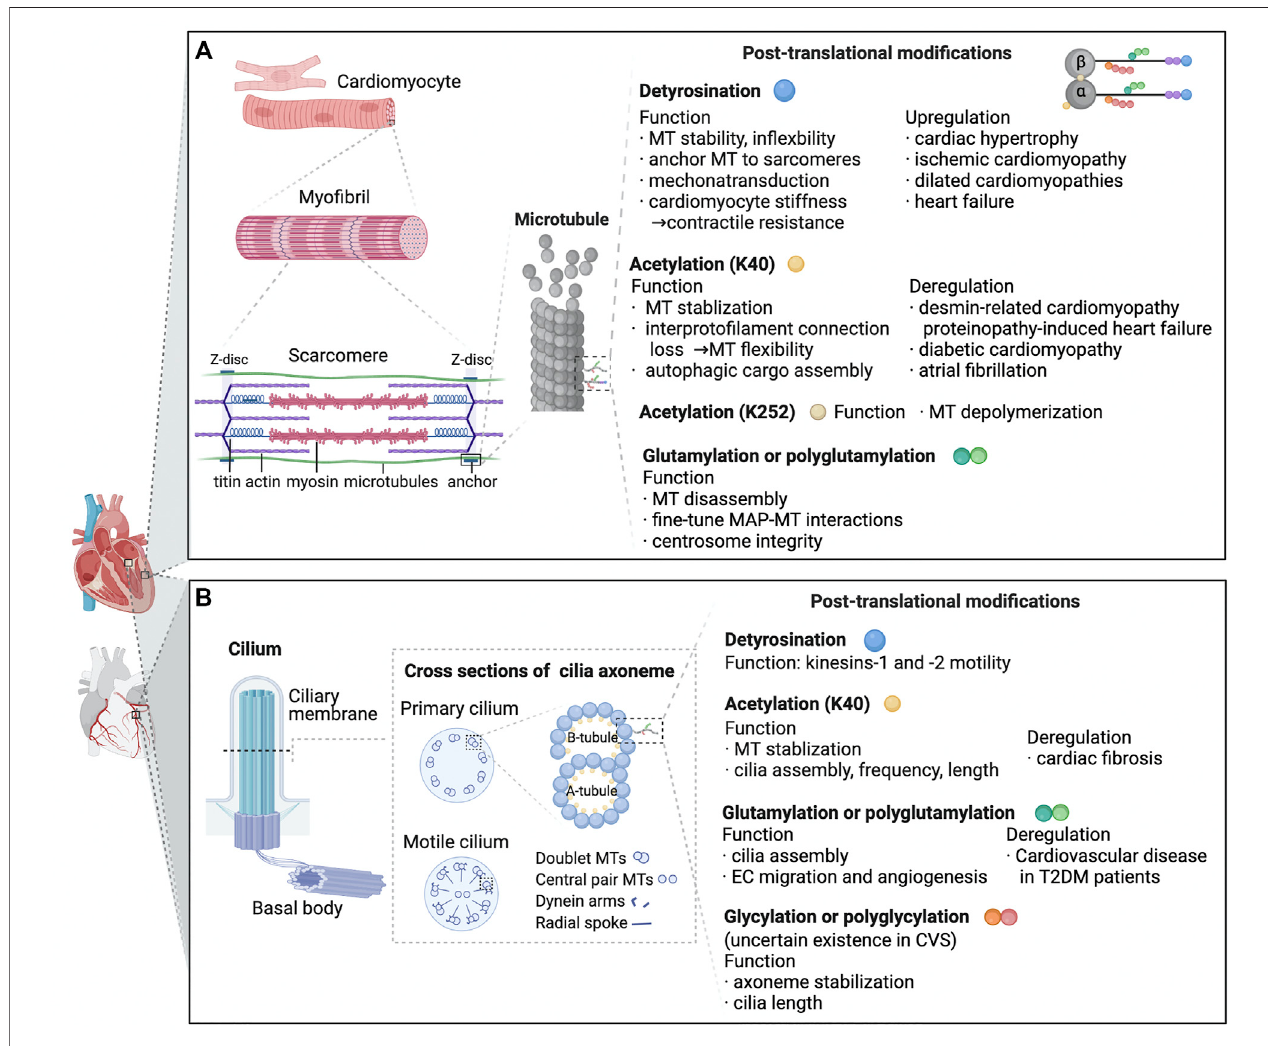
FIGURE 2 | Known functions and pathologic roles of tubulin post-translational modi fi cations (PTMs) in cardiomyocytes and cardiac primary cilia are depicted. (A) Myocardiocytes. In cardiomyocytes, microtubules predominantly grow along the long axis of the cell, interdigitating with the myo fi brils. In a beating heart, when sarcomeresshortenandstretch,microtubulesbuckleunderload.PTMsgeneratedonthetubulinbodyandC-terminaltailspossessvariousfunctionswhichareessential formicrotubuleproperties,MAPinteractionsandcellcontraction.Aslistedinthe fi gure,deregulationofPTMsislinkedtoarangeofcardiacdysfunctions. (B) Cilia.A cilium assembles from the axoneme contiguous with the basal body. The axoneme comprises doublets built by 13 tubulin proto fi laments (A-tubule), and an incomplete microtubulecontaining10proto fi laments (B-tubule). In9+2motilecilia,the9doublets areintegratedintoacylindricarraywithradialspokesand dyneinarms.Primary9 + 0 cilia do not possess dynein arms, radial spokes or central pairs. Axonemal microtubules are modi fi ed by a range of tubulin PTMs, exerting various effects on microtubules and cilia-related disorders. Abbreviations: K40, lysine 40; MT,microtubule; K252, lysine 252; MAP, microtubule-associated protein; EC, endothelial cells; T2DM, type 2 diabetes mellitus; CVS, cardiovascular